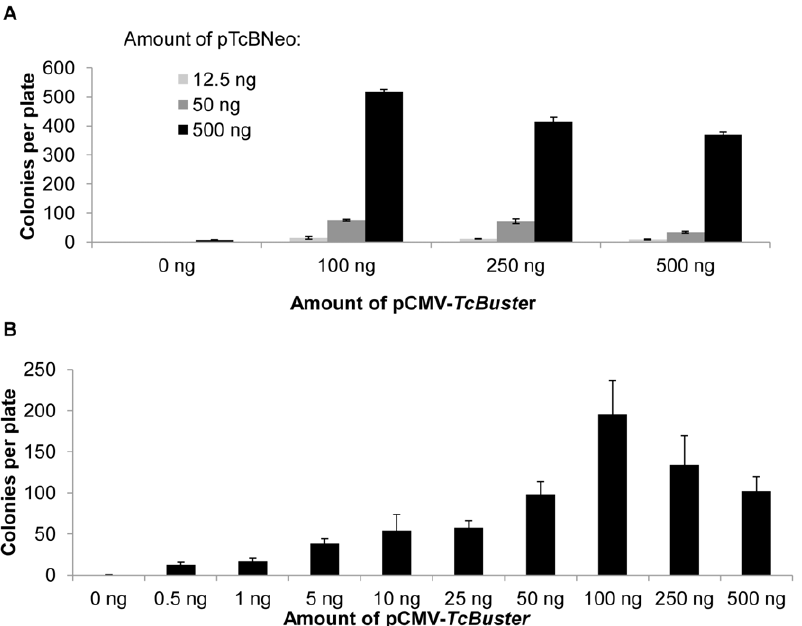
Figure 2. The effect of transposon and transposase plasmid dose on the number of drug-resistant colonies formed. ( a ) HEK-293 cells in 6-well plates were transfected in triplicate with either 12.5 ng (light grey bars), 50 ng (dark grey bars), or 500 ng (black bars) of pTcBNeo carrying the neomycin-resistance transposon and 0 ng, 100 ng, 250 ng, or 500 ng of pCMV- TcBuster expressing the transposase. ( b ) HEK-293 cells in 6-well plates were transfected in triplicate with 500 ng of pTcBNeo plasmid carrying the neomycin-resistance transposon and the indicated amount of pCMV- TcBuster (0.5 ng, 1 ng, 5 ng, 10 ng, 25 ng, 50 ng, 100 ng, 250 ng, or 500 ng). In both a and b , pUC19 was used as filler DNA to increase the total amount of DNA transfected to 1 m g. Cells were diluted 1:750 in selection media and grown for two weeks to allow drug-resistant cells to multiply and form colonies. The colonies were fixed, stained, and counted. The mean and standard error of the mean (SEM; n=3) are shown.